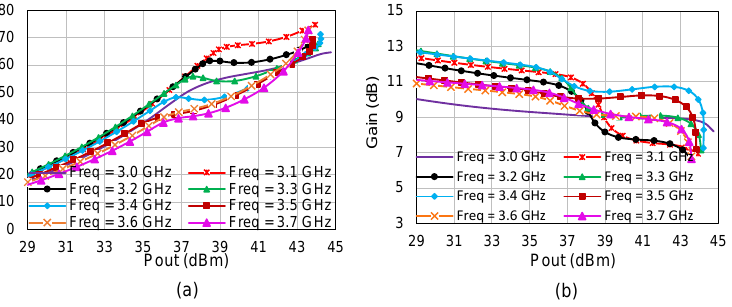
Figure 6. Simulated ( a ) drain efficiency and ( b ) gain of the designed DPA versus output power. A two-tone analysis is also performed at 3.5 GHz to evaluate the linearity of the DPA. The third and fifth order intermodulation distortion (IMD3 and IMD5), shown in Figure 7a versus output power, remain better than − 20 dBc and − 31 dBc, respectively, for P out < 43 dBm. In order to assess the system-level behavior, the DPA is simulated using a 16-QAM modulated signal and 6 dB PAPR. The input and output power spectrum at the center frequency of 3.5 GHz and with 5 MHz bandwidth are shown in Figure 7b. At an average output power of 36 dBm, the simulated ACPR is − 30 dBc, and which is comparable to the results shown in